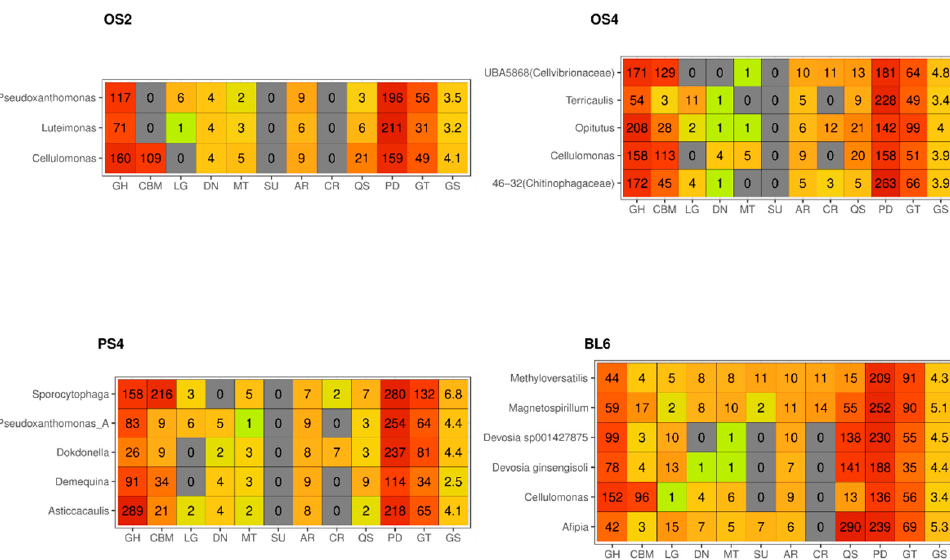
Figure 5. MAGs from the four consortia and representation of functional genes related to substrate decomposition and microbial interactions. Heatmaps are based on the DRAM annotation. Increased hit value relative to the dbCAN/EggNOG annotation caused by using a greedier algorithm.